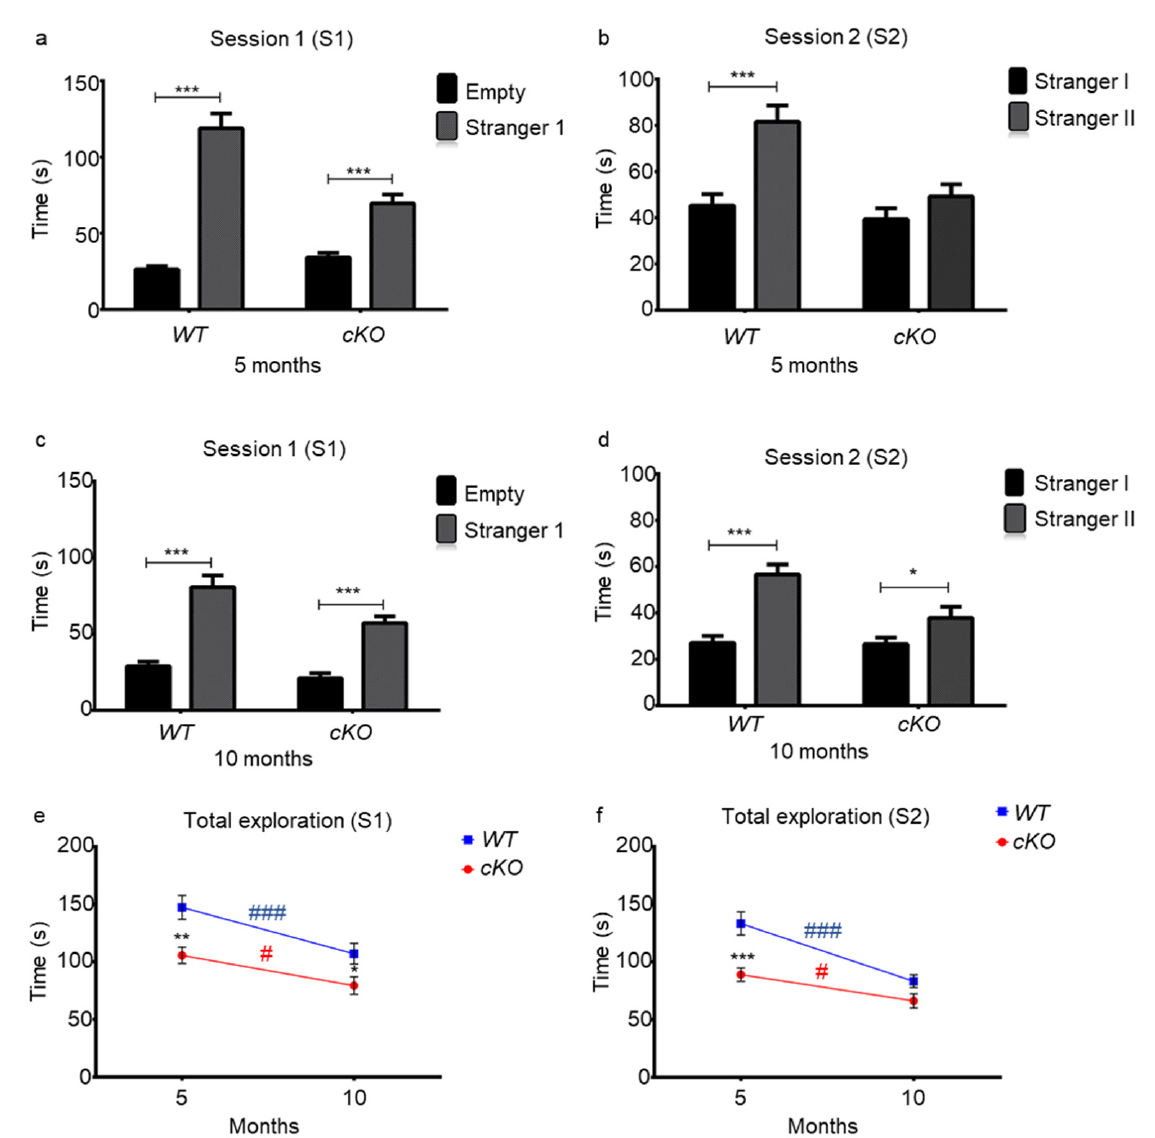
Figure 5. Sociability and social novelty assessment of WT ( n = 20) and cKO ( n = 18) mice. 5- ( a , b ) and 10- ( c , d ) month-old mice. ( a , c ) Session 1 (S1): exploration time (s) of stranger 1 vs. empty cup. ( b , e ) Session 2: exploration time (s) of stranger 1 used in S1 and a novel stranger. ( e ) Total explora- tion time in S1, in seconds, at 5 and 10 months of age. ( f ) Total exploration time (s) in S2 at 5 and